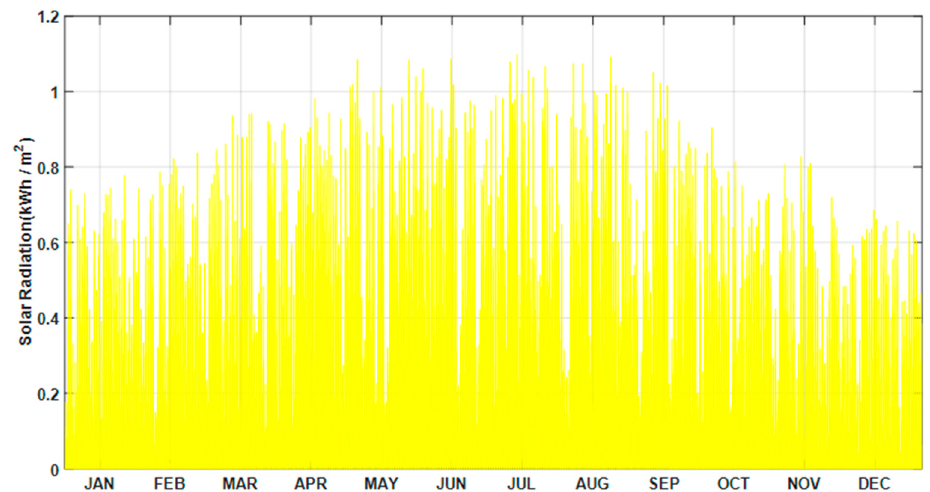
Figure 3. The time sequence of solar radiation intensity in a whole year predicted by HOMER. The ordinate is solar radiation intensity and unit is kWh/m 2 .